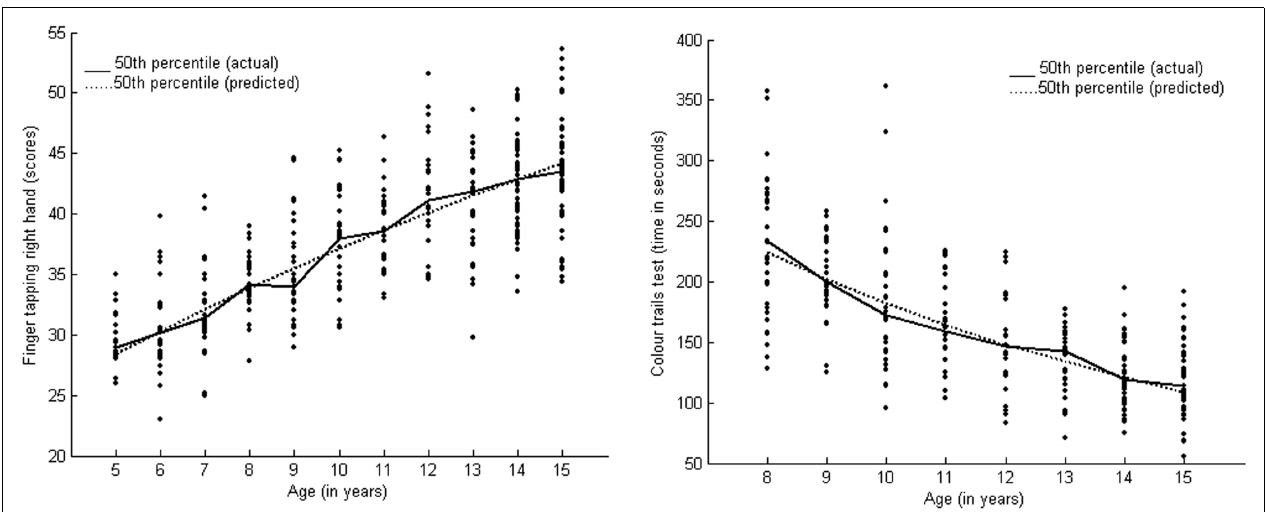
FIGURE 2 | Presents exemplars of the exponential association (motor speed for right hand) and exponential fit (focused attention) growth